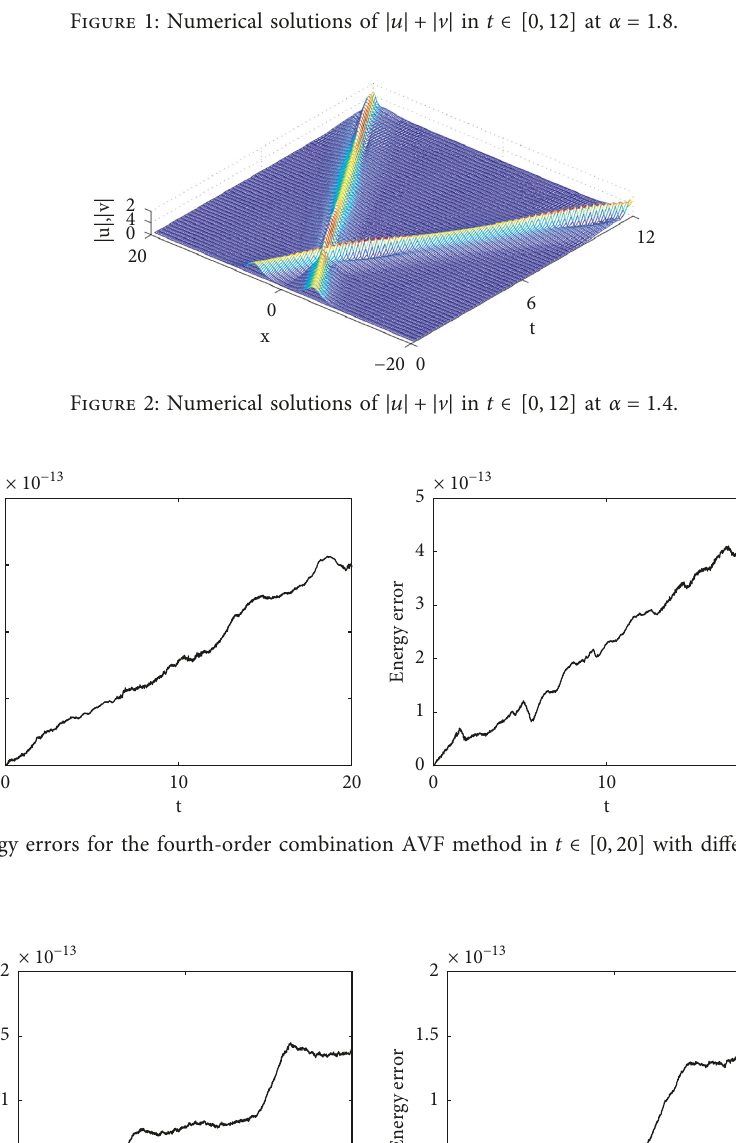
Figure 1: Numerical solutions of